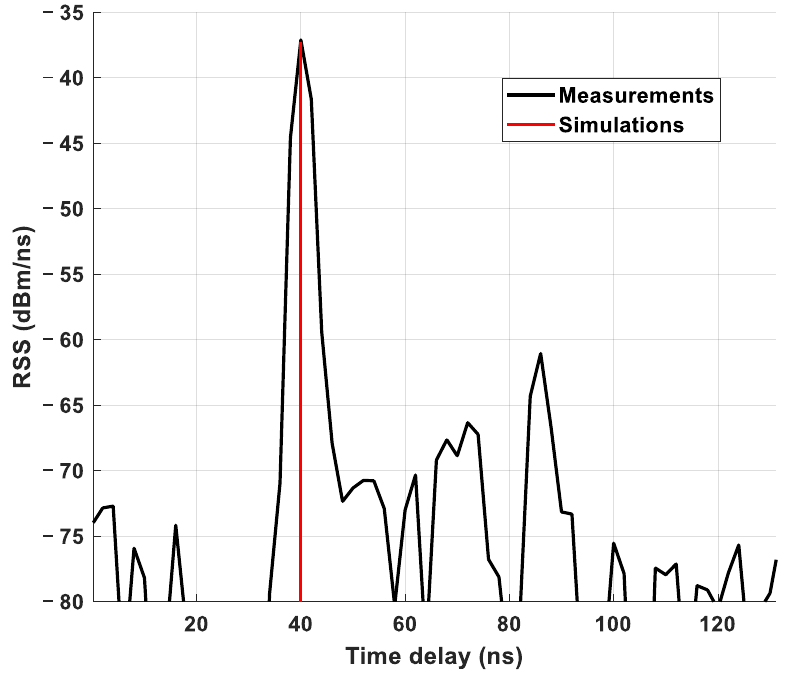
Figure 16. PDP at Rx3_150.